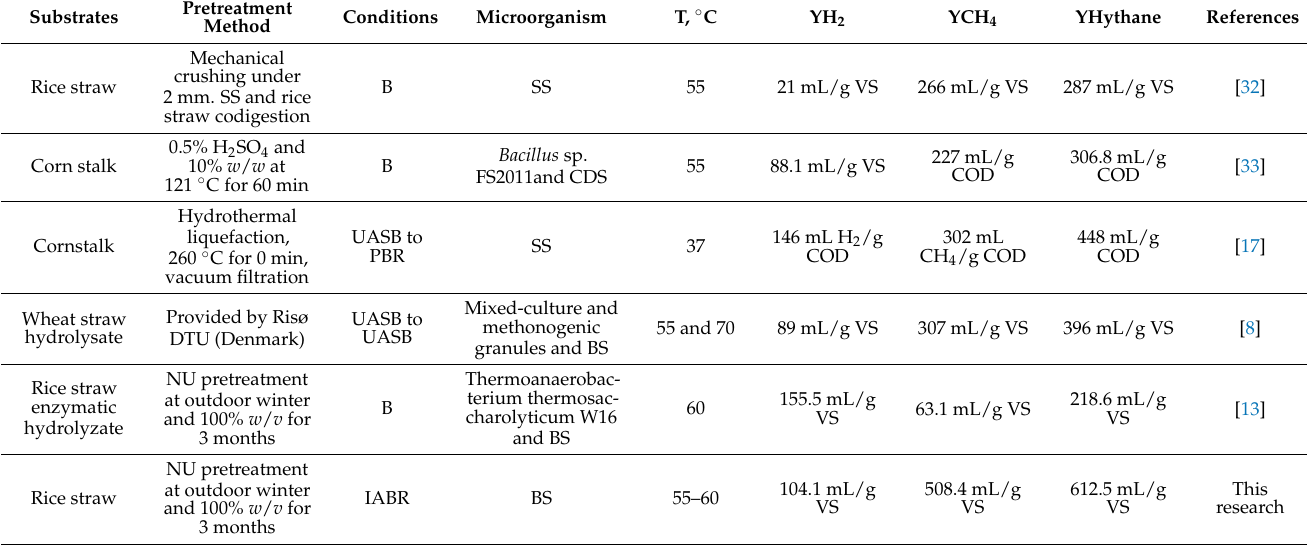
Table 1. Comparison of hythane yields with other relative